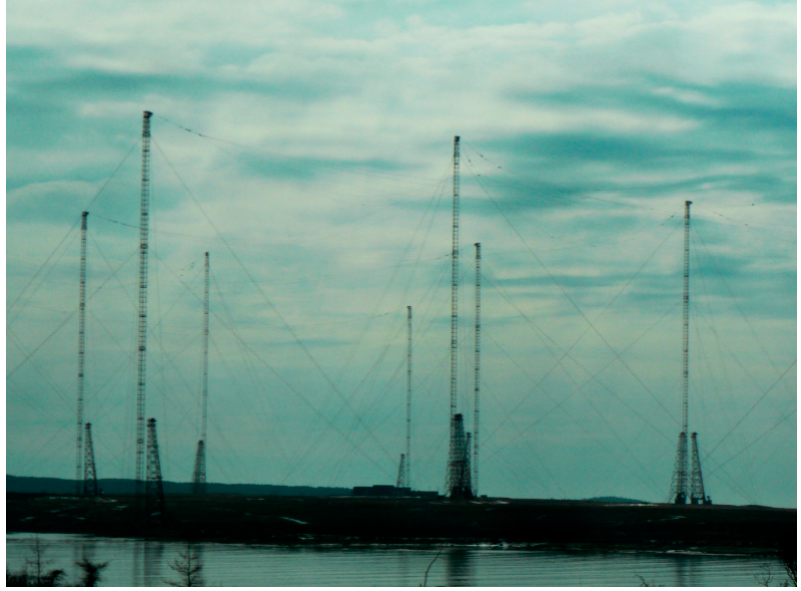
Figure 1. Very low frequency (VLF) antenna of the US Navy.